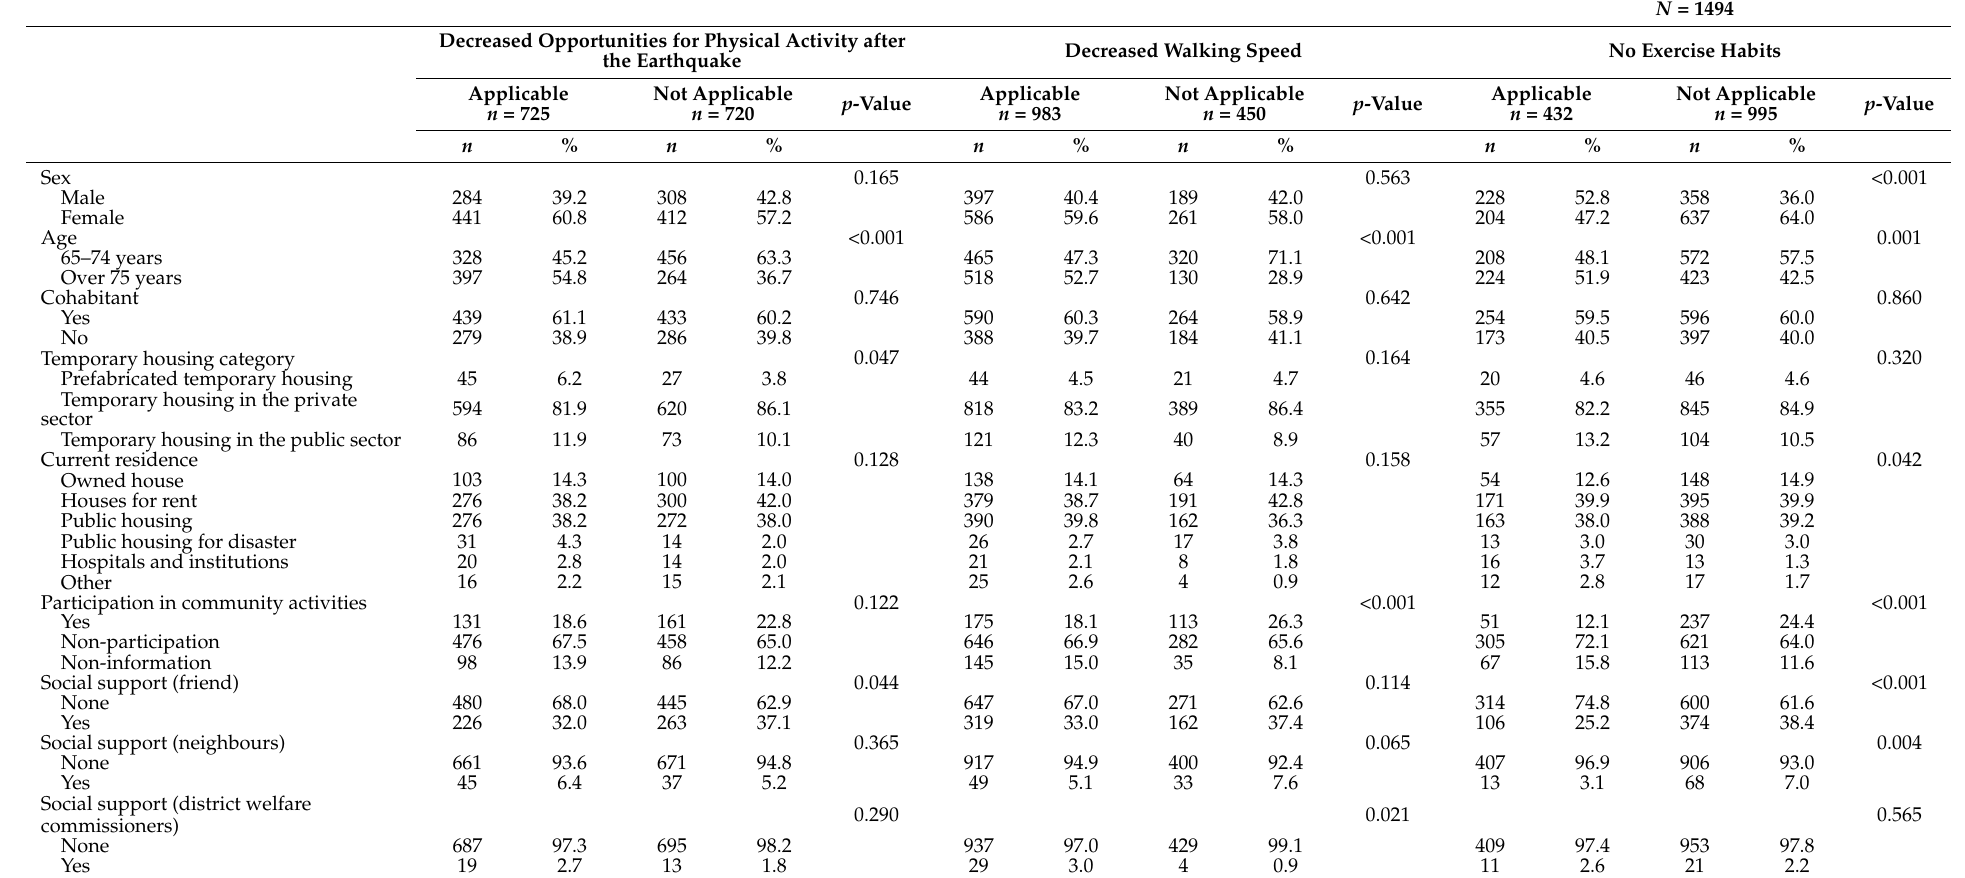
Table 3. Cross tabulation of social support and independent